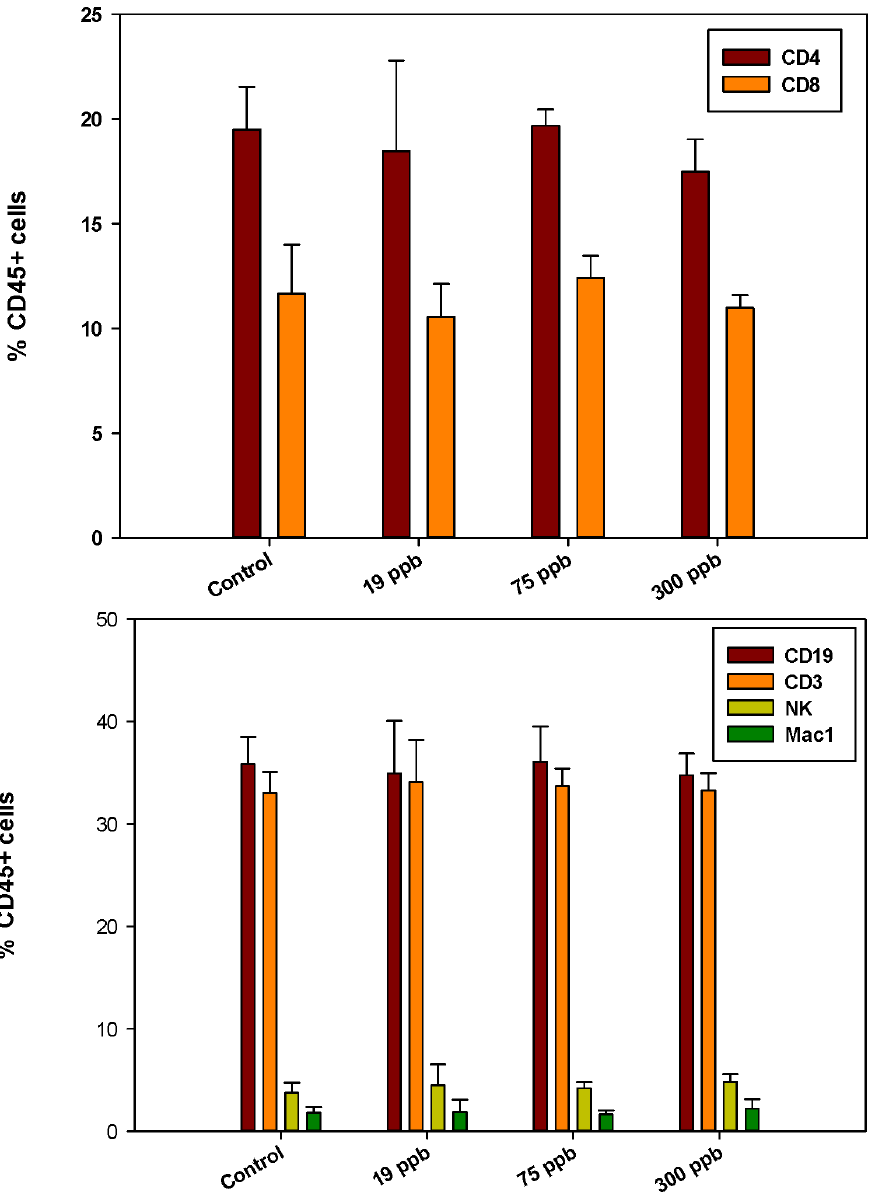
Figure 2. Spleen cell surface marker expression analysed by flow cytometry. Percent CD19 + , CD3 + , NK and Mac 1 cells co-expressing CD45 [Top] and percent CD4 + or CD8 + cells co-expressing CD45 [Bottom] after 30 day consumption of As + 3 in drinking water. Results are Means +